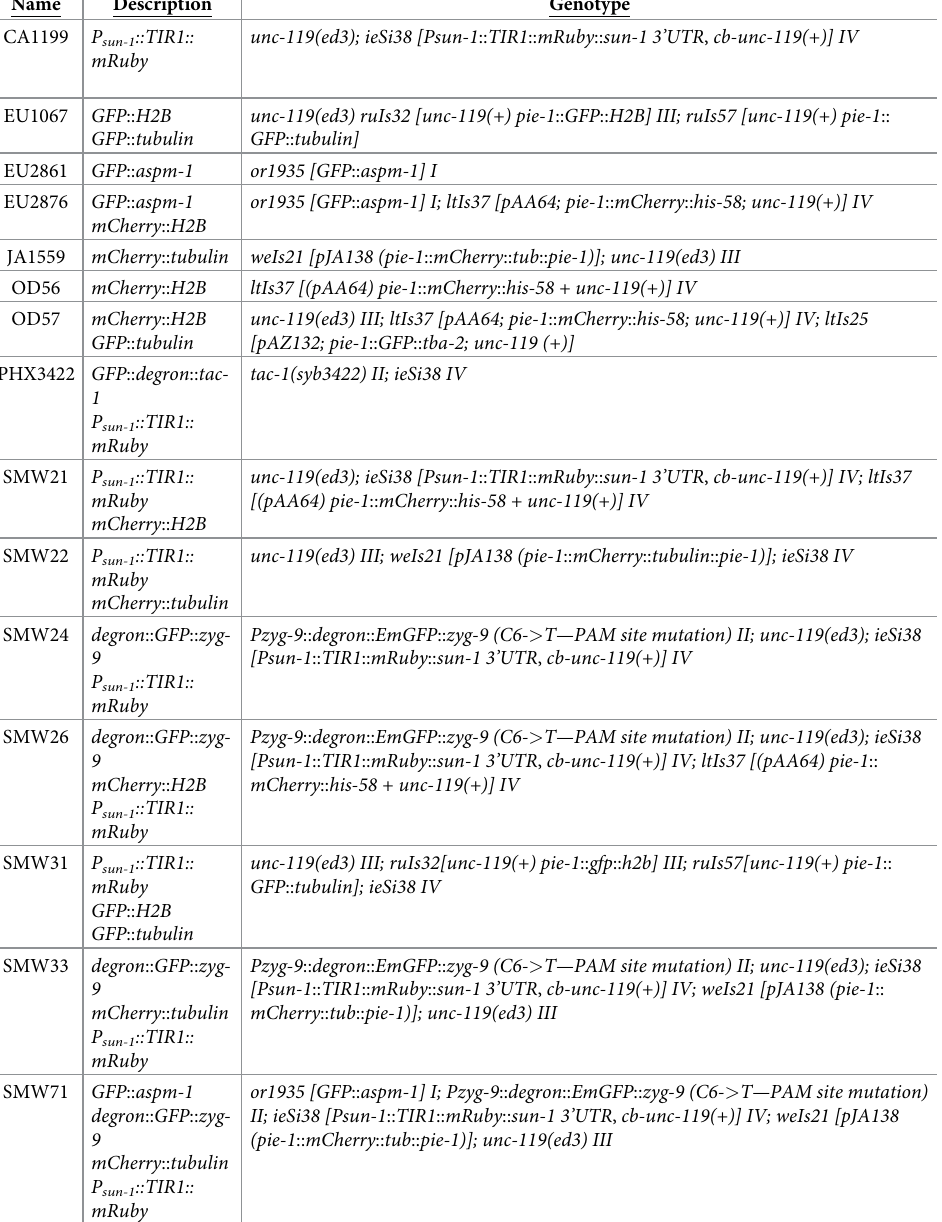
Table 1. Strains used in this